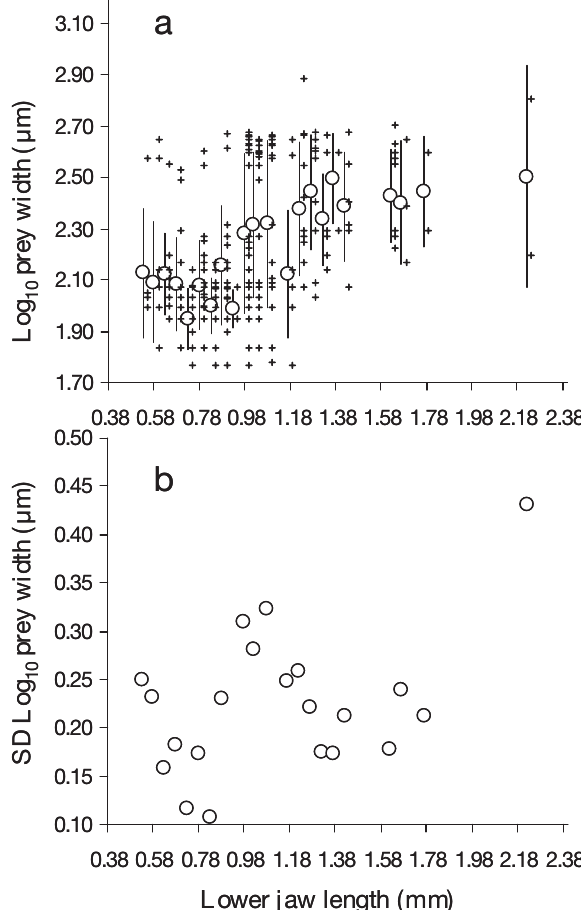
F IG . 2. – a) Raw data (dots), means (circles) and standard deviation (lines) of prey width in relation to larval LJL classes; b) Niche breadth in relation to larval T. alalunga LJL classes. Raw data are shifted slightly to the right to facilitate visualisation.